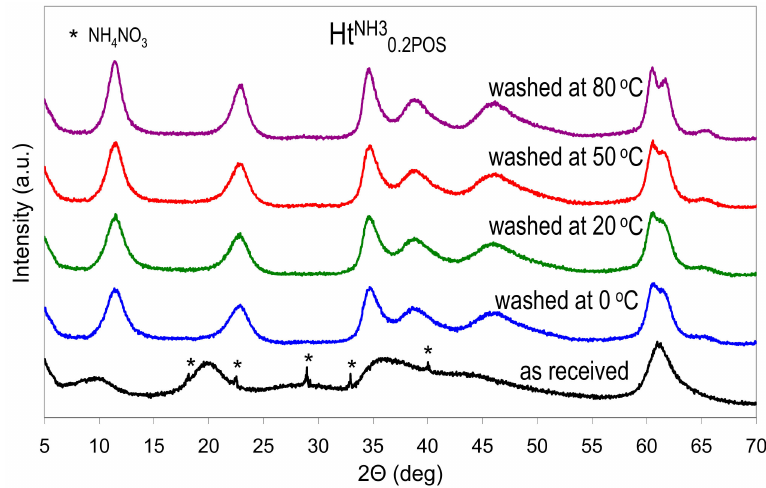
Figure 4. Structural changes in the Ht NH3 0.2POS sample upon washing with water at di ff erent temperatures. All materials freeze dried. Table 3. The e ff ect of washing with water on XRD determined d 003 and d 110 interplanar spacings,